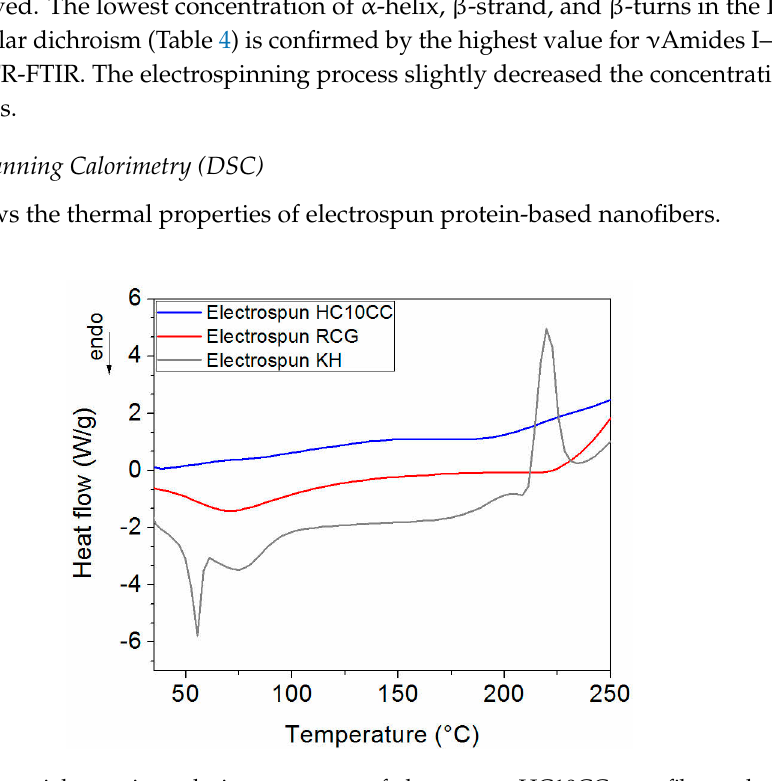
Figure 4. Differential scanning calorimetry curves of electrospun HC10CC nanofibers, electrospun RCG nanofibers, and electrospun KH nanofibers.